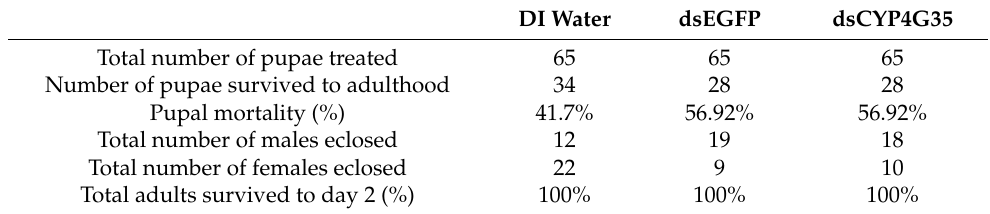
Table 1. Emergence rate, sex assessment, and adult survival in control (DI water and EGFP dsRNA- treated) and CYP4G35 dsRNA-treated Aedes aegypti